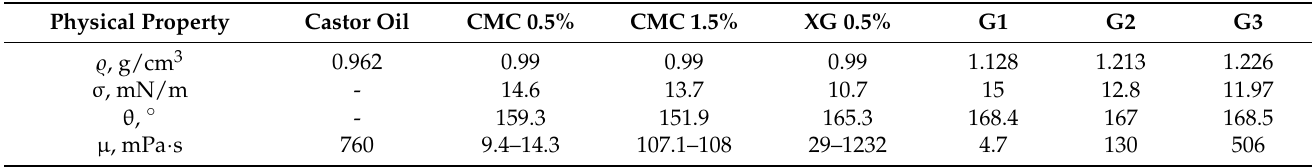
Table 1. Physical properties of the liquids used in the experiments @ 23 ◦